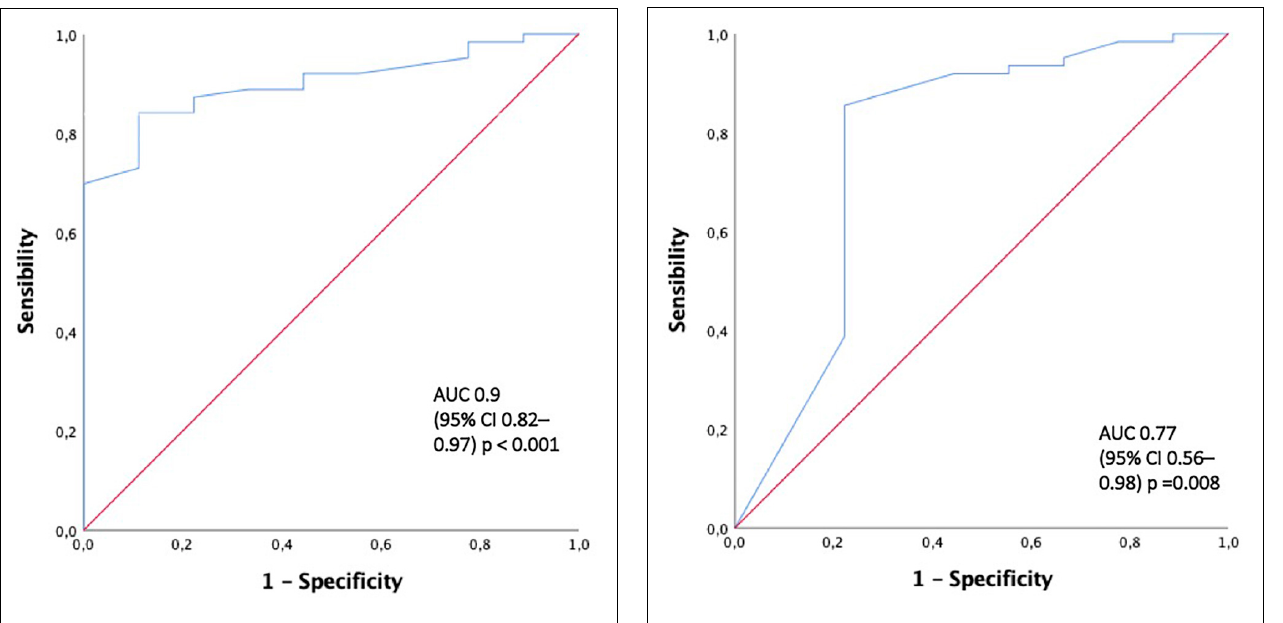
FIGURE 4 | The ROC curve for predicting end-renal stage disease development with > 50% of crescents. AUC area under the curve, ROC curve receiver-operating characteristic